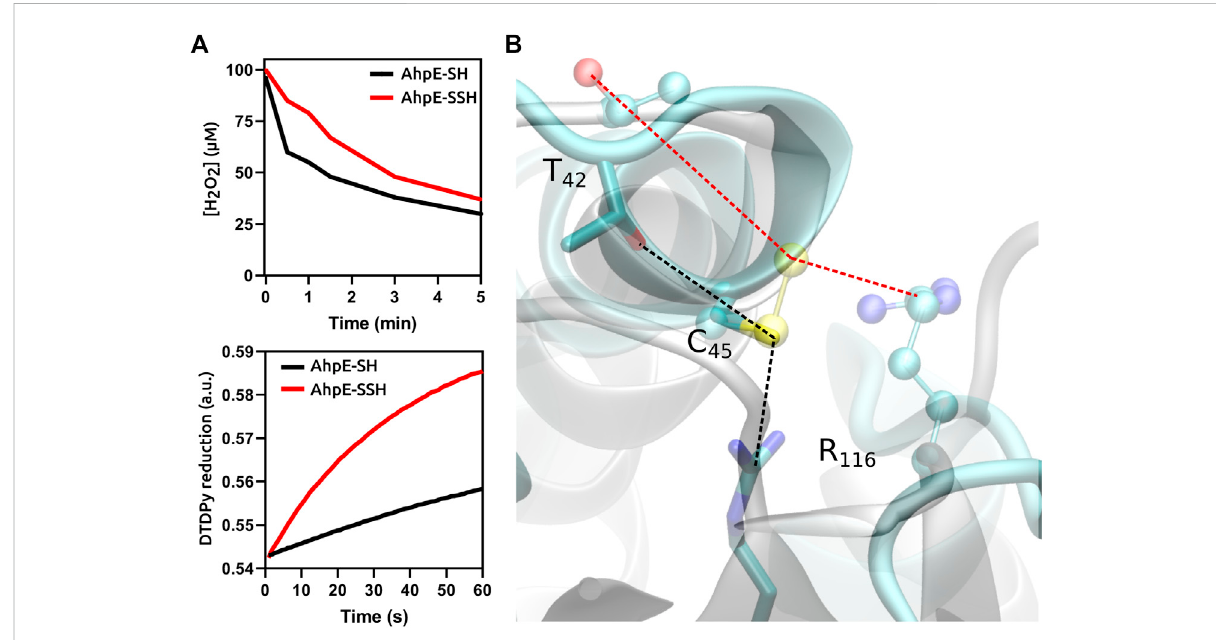
FIGURE 2 Functional and structural consequences of the persul fi dation of the reactive cysteine in Mt AhpE. (A) Time courses comparison of the reactions of native (thiol, black) and persul fi dated (red) enzymes with H 2 O 2 (one of its physiological substrates, top) or 4,4 ′ -dithiodipyridine (DTDPy, synthetic unspeci fi c substrate, bottom) as electrophiles. (B) Superposition of representative structures of native (cyan, sticks)and persul fi dated (gray, balls and sticks) Mt AhpE active sites. Dotted lines indicate the distances of the key interactions among the peroxidatic cysteine and threonine or arginine residues that form the catalytic triad (black, native; red, persul fi dated). Modi fi ed from (Cuevasanta et al.,